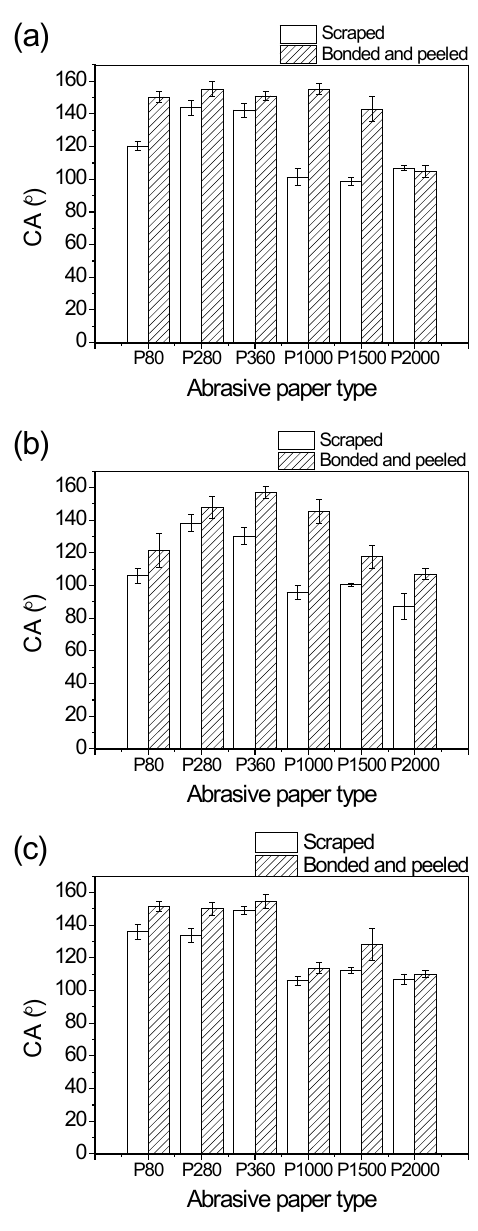
Figure 3: The CAs of HDPE (a), LDPE (b) and PP (c) surfaces after being scraped and then bonded and peeled.